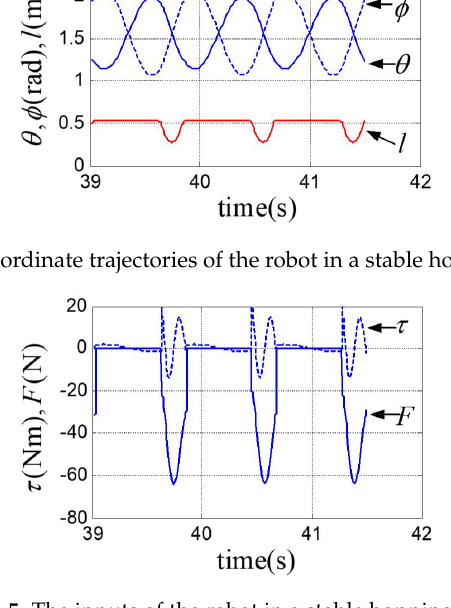
Figure 5. The inputs of the robot in a stable hopping orbit. Table 1. The model parameters of the hopping robot.